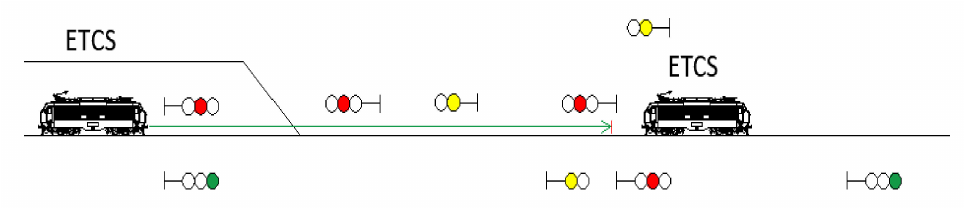
Figure 1. Monitoring line sections according to braking